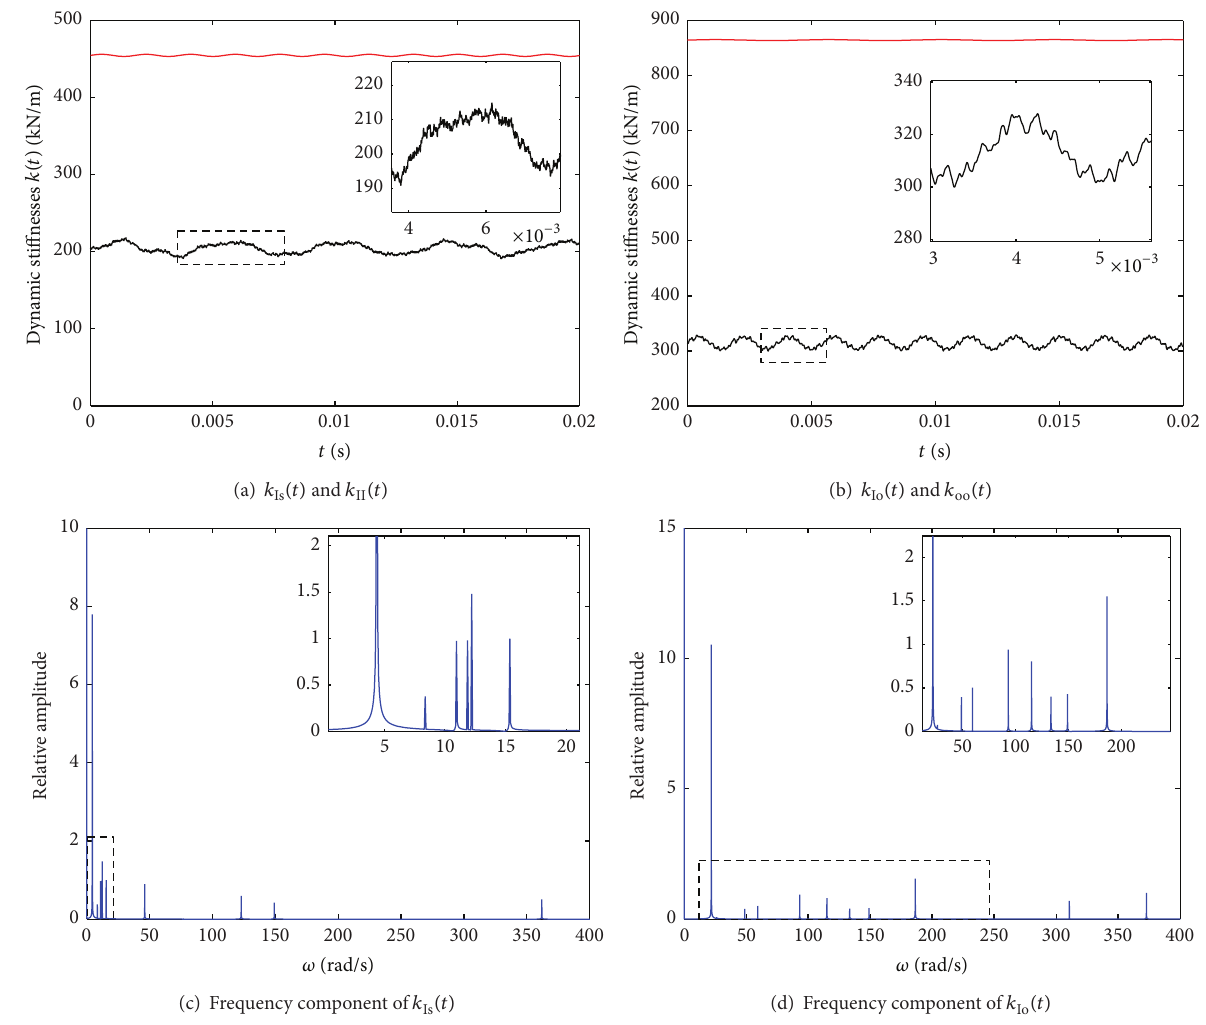
Figure 3: Dynamic electromagnetic coupling stiffnesses among